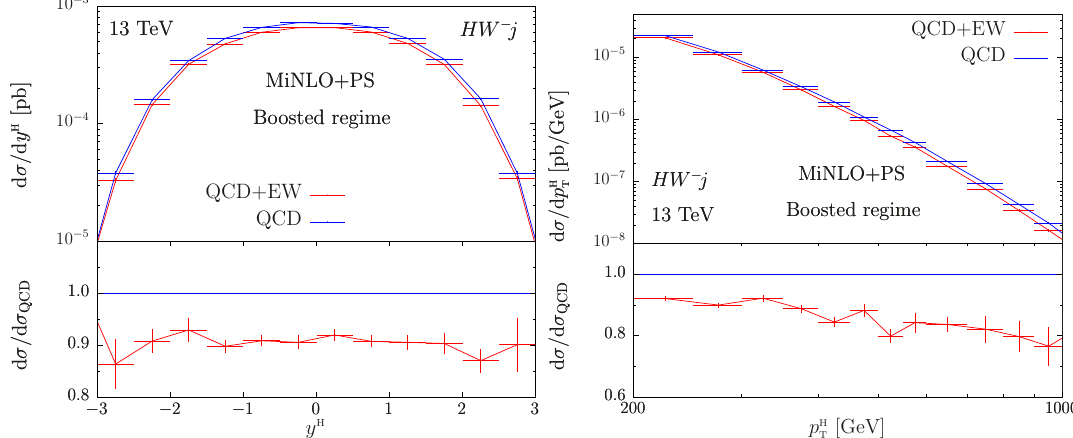
Figure 20. MiNLO +PS predictions for the rapidity (left) and transverse-momentum distribu- tion (right) of the Higgs boson in the boosted regime, in HW (cid:0) j production. Comparison between the full QCD+EW results and the QCD ones after the Pythia 8.1 QCD+QED shower.